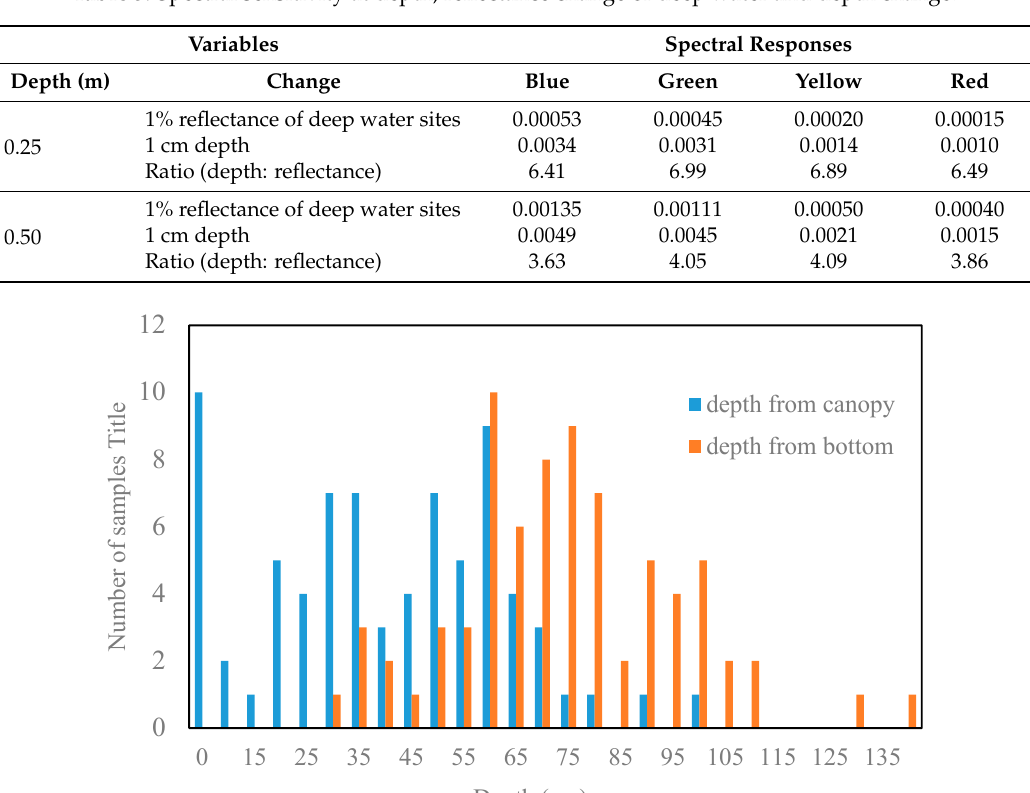
Figure 6. Reflectance of clean Thalassia blade, Thalassia blade with epiphyte, Halodule blade with epiphyte, draft algae, Thalassia canopy under 0.5 m water surface.